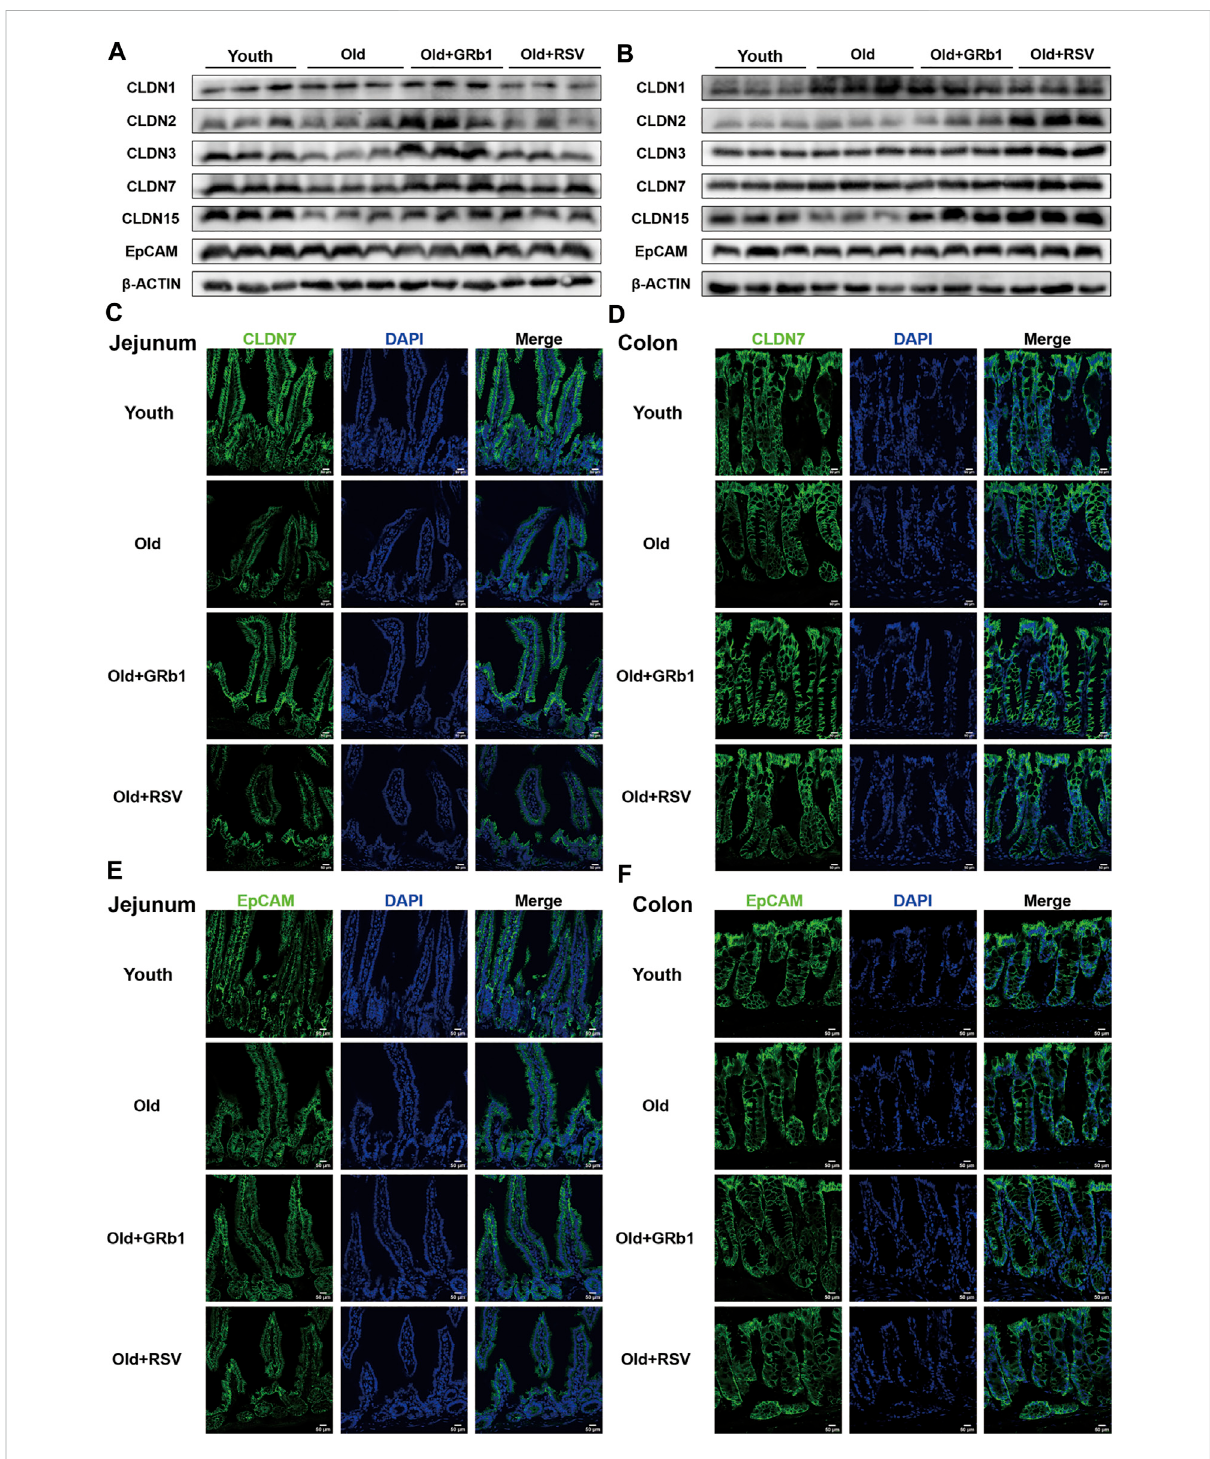
FIGURE 2 GRb1 improved the expression and localization of junctional proteins in the intestines of old mice. (A,B) Images of Western blot bands of CLDN 1, 2, 3, 7,15, and EpCAM in the (A) jejunum and (B) colon. (C,D) Representative images of immuno fl uorescence staining with antibodies to CLDN 7 of frozen sections of (C) jejunum and (D) colon. (E,F) Representative images of immuno fl uorescence staining with antibodies to EpCAM of frozen sections of (E) jejunum and (F) colon. Scale bar, 50 μ